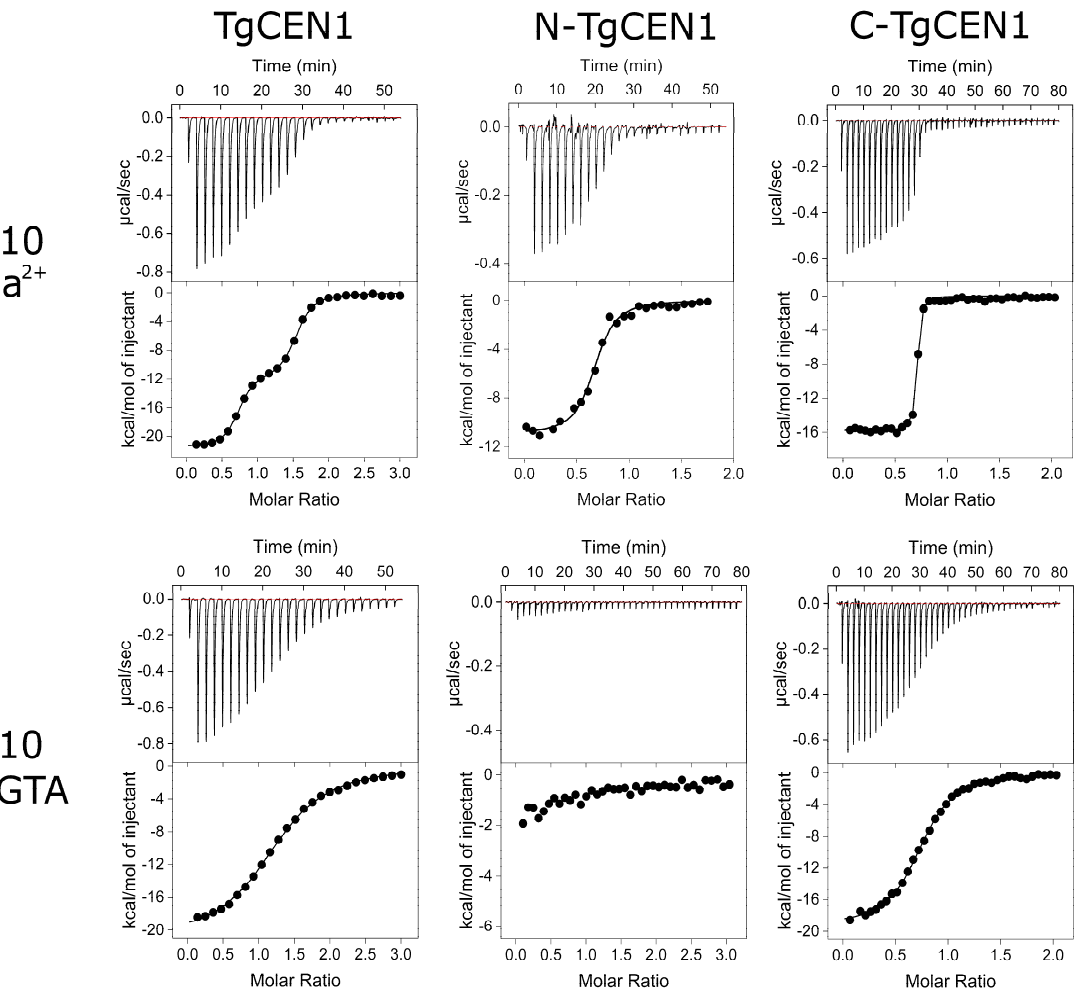
Figure 2. ITC characterization of the interactions of TgCEN1 and its domains with the R10 peptide in the presence of CaCl 2 or EGTA. Representative thermograms (top panels) and the derived binding isotherms (bottom panels) of titration of R10 into TgCEN1, N-TgCEN1, and C-TgCEN1 in the presence of 5 mM CaCl 2 or 5 mM EGTA at 25 °C. The ligand dilution blank experiments (peptide titrated into buffer) were subtracted from the binding isotherm obtained in the presence of protein. The first injection of 0.2 μ L was made, and then the first data point was removed from data fitting. Peptides R12 and R5 also showed significant binding to TgCEN1 (Figure 3B). In these peptides, Trp1 is conserved, Leu4 is substituted with Phe or Trp, and Leu8 is the least conserved residue with Val or Ile substitutions (in R5 and R12, respectively) (Figure 1B). In the presence of Ca 2+ , the binding isotherms best fit a single-binding site model, with a K d of ~0.5 μ M. Interestingly, after removal of Ca 2+ , the affinity of R12 and R5 for TgCEN1